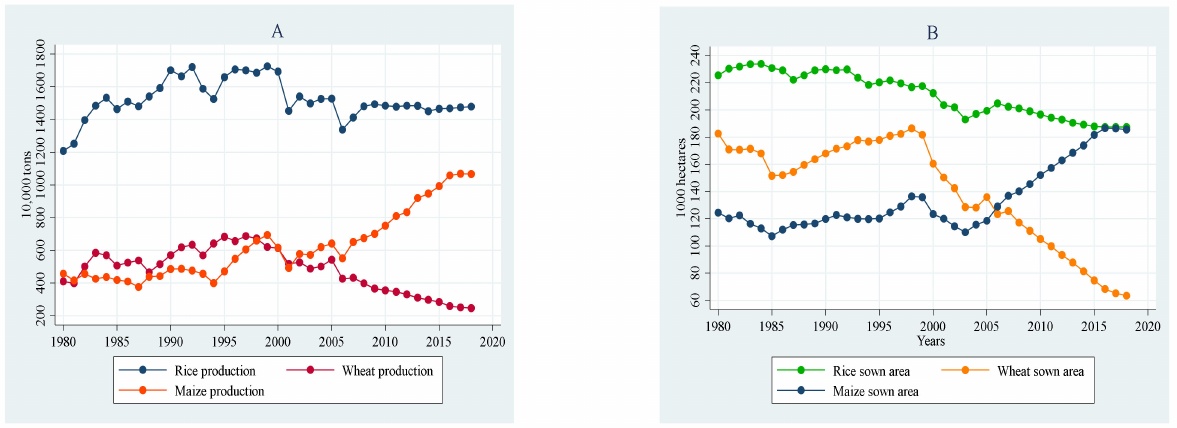
Figure 1. Production ( A ) and sown area ( B ) of food crops in Sichuan province. (Source: China Rural Statistical Yearbook of Sichuan Province [20]).